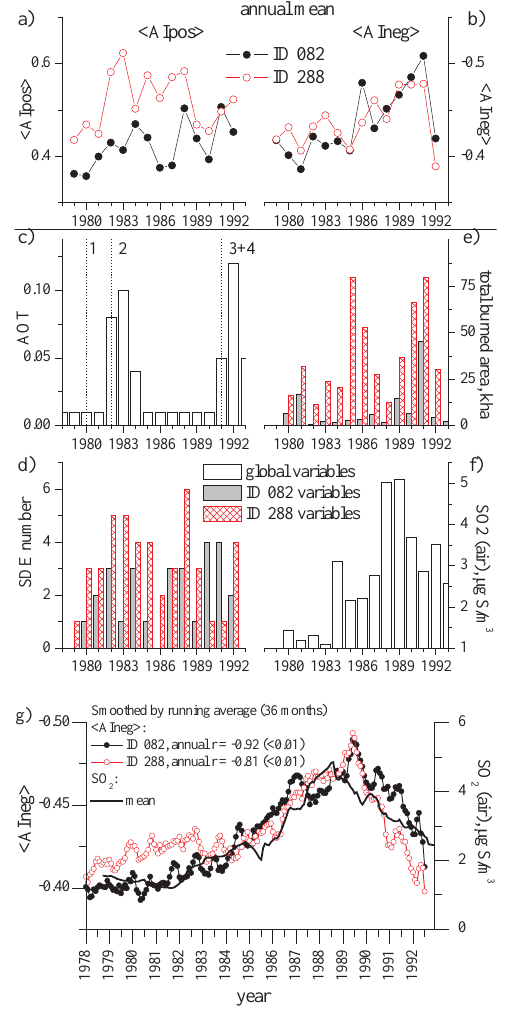
Figure 2. (a – b) Annual variations of aerosol indices (cid:104) AIpos (cid:105) (a) and (cid:104) AIneg (cid:105) (b) for two locations: ID 082 and ID 288. (c – f) Annual values of parameters describing aerosol forcings: volcanic aerosols ( c – AOT, annual means), Saharan dust events ( d – annual sums for two AI locations), wildfires ( e – total annual burned area close to AI locations) and anthropogenic sulfates ( f – SO 2 , annual means). The four most significant volcanic eruptions are marked in c by vertical lines: 1 – Mt. St. Helens, 2 – El Chichon, 3 – Pinatubo and 4 – Mt. Hudson. (g) Monthly variations of SO 2 and aerosol indices (cid:104) AIneg (cid:105) for two sites (ID 082 and ID 288) smoothed by the 36- month running averaging. Correlation coefficients ( r) are between the AI and the sulfate series ( p values are shown in brackets). Please note the inverted y axes in (b) and (g)